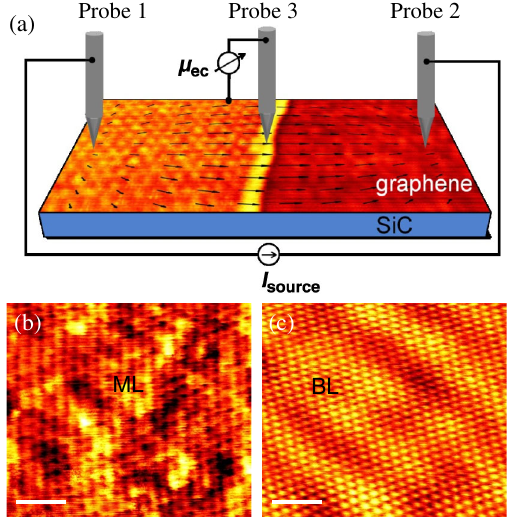
FIG. 2 (color online). (a) Schematic of the STP measurement setup. STM images of (b) ML and (c) BL graphene. Scale bar: 1